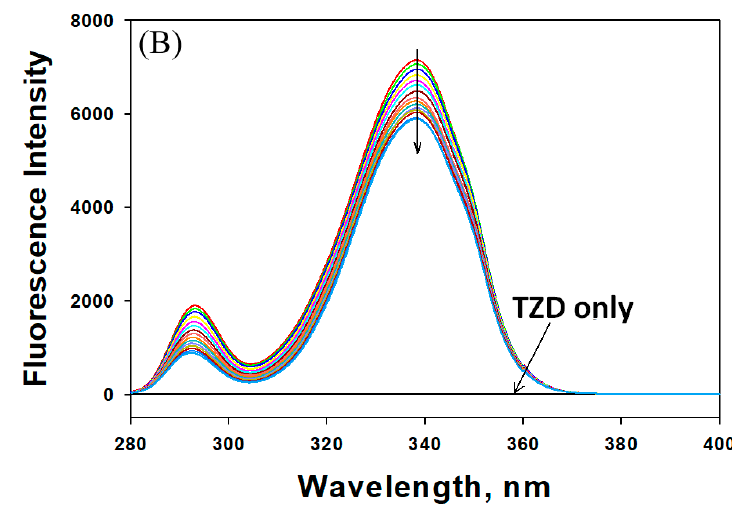
Figure 5. Synchronous fluorescence spectra of HSA in the absence or presence of different concentrations of 2,4-TZD. The difference in excitation and emission wavelength ( ∆λ ) was ( A ) 15 nm for the Tyr microenvironment and ( B ) 60 nm for the Trp microenvironment.